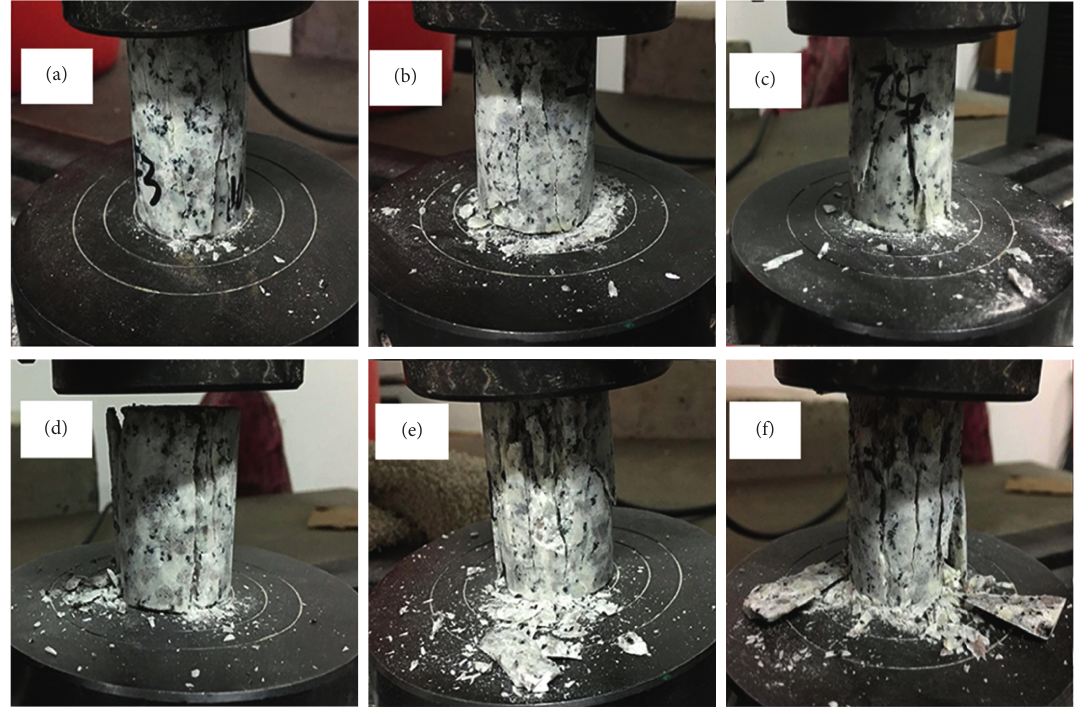
Figure 11: Crushing state of samples in compressive strength test ((a) without ultrasonic vibration. (b) (c), (d) (e), and (f) are applied with 100N, 200N, 300N, 400N, and 500N static loadings combined with ultrasonic vibration, respectively).